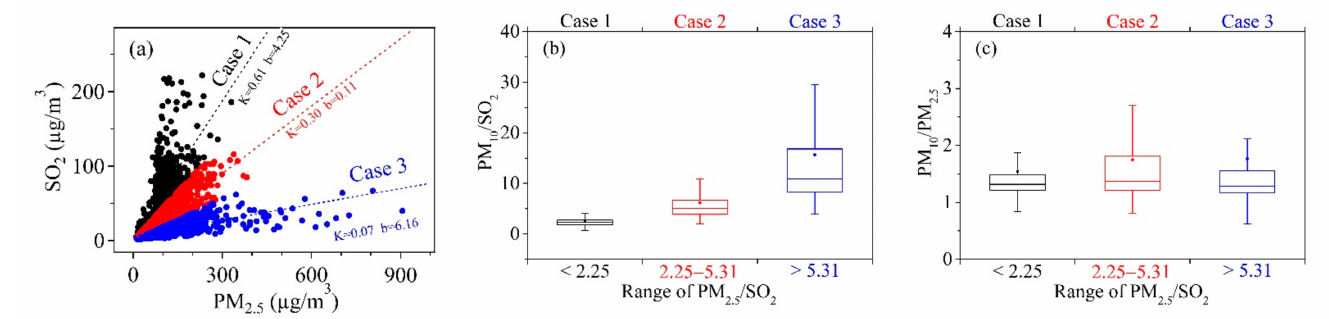
Figure 6. ( a ) The scatter plots of the PM 2.5 and SO 2 . Case1, Case2, and Case3 represent PM 2.5 /SO 2 ratios ranging from <2.25, 2.25–5.31, and >5.31, respectively. ( b ) The PM 10 /SO 2 ratio of Case 1, Case 2, and Case 3. ( c ) The PM 10 /PM 2.5 ratio of Case 1, Case 2, and Case 3.